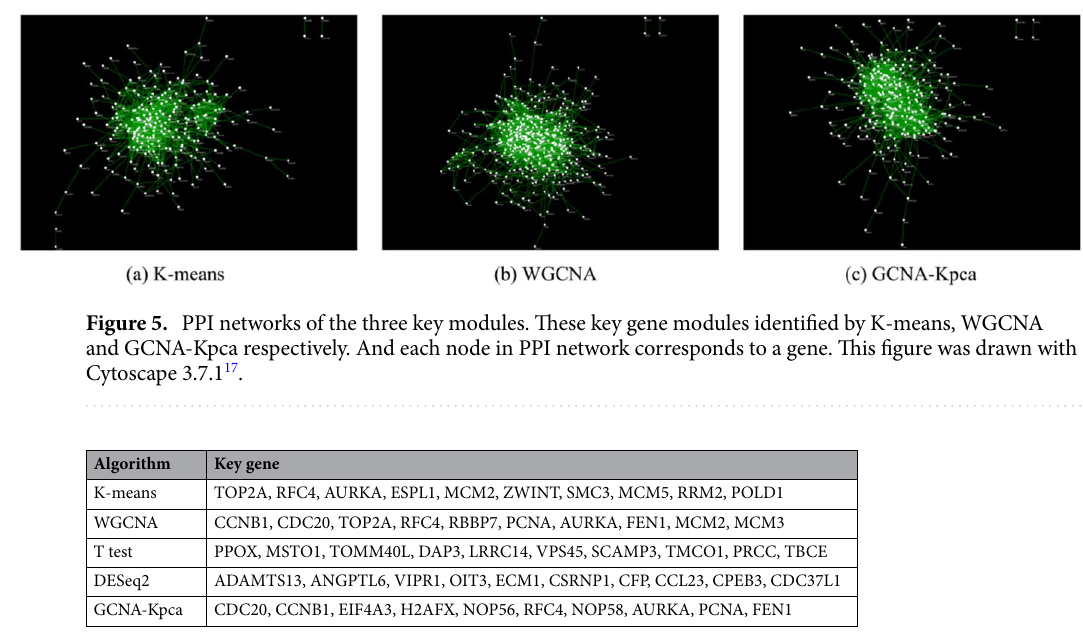
Table 4. Key genes identified by five algorithms (K-means, WGCNA, T test, DESeq2 and GCNA-Kpca).